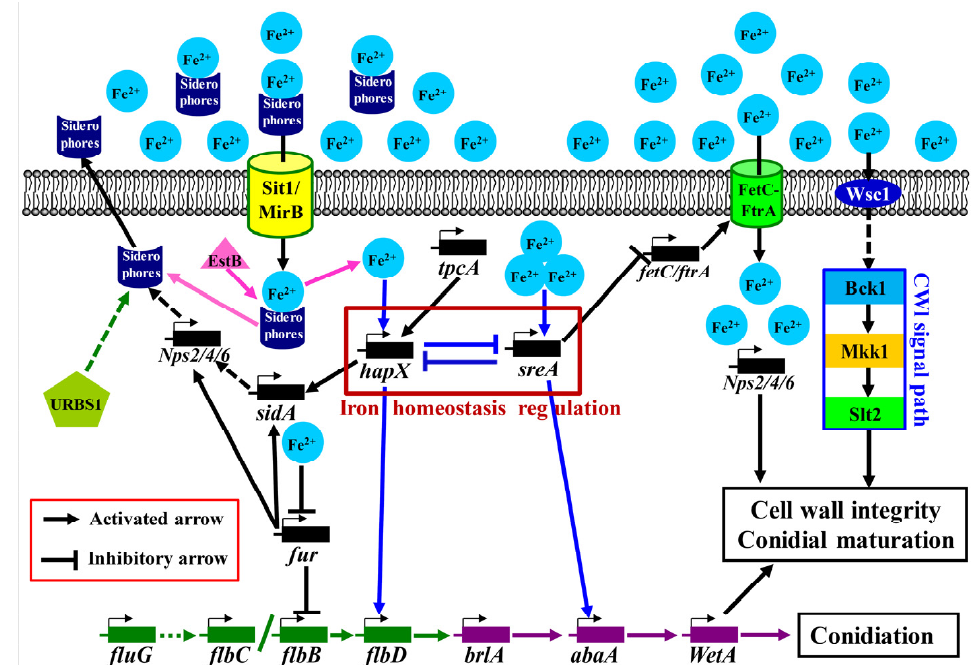
Figure 5. Model diagram of the Fe 2+ - and FluG-mediated signal pathway of the asexual sporulation of A. cinnamomea in submerged fermentation. Note: “green arrow”, upstream developmental activation pathway; “purple arrow”, central developmental pathway; “blue arrow”, iron homeostasis regulator pathway.